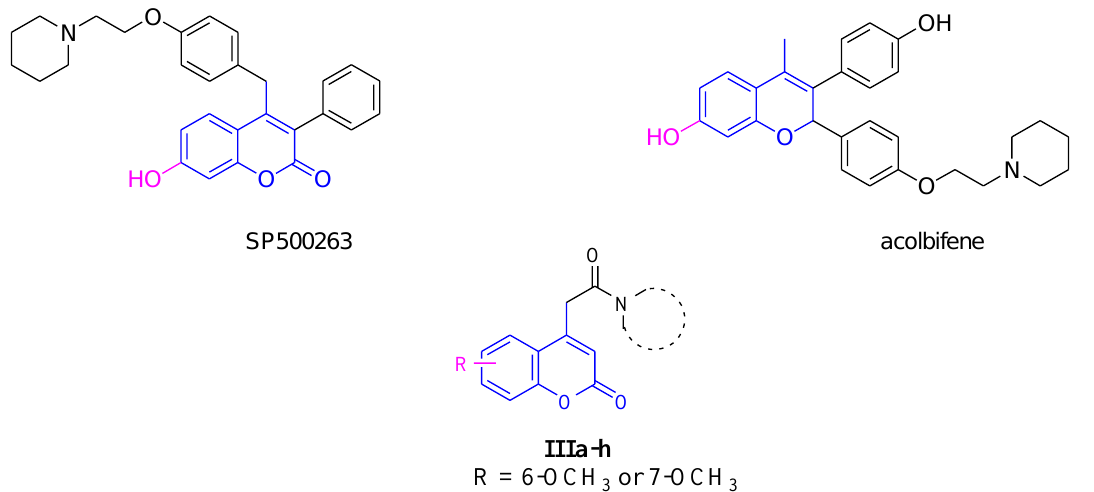
Figure 1. Chemical structures of SP500263, acolbifene, and the target compounds IIIa-h .